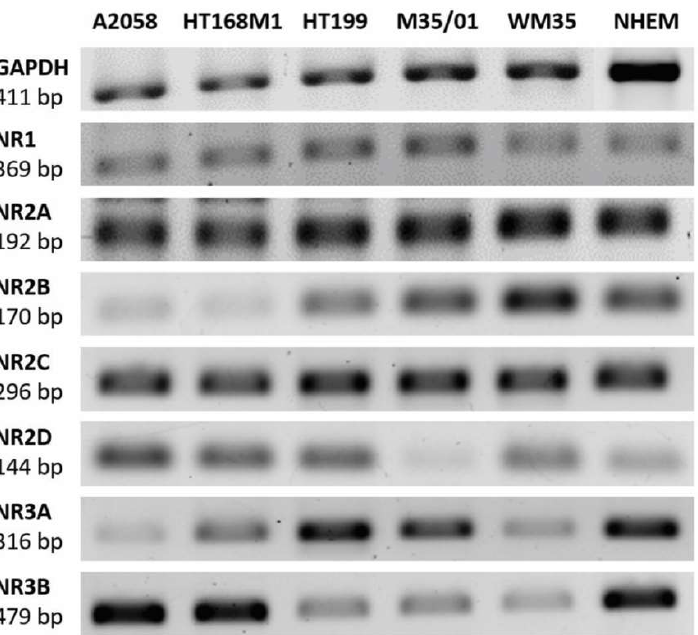
Figure 1. RT-PCR (reverse transcription followed by polymerase chain reaction) detection of NMDAR ( N -methyl- D -aspartate receptor) subunit mRNA expression in melanoma cells and melanocytes. RT-PCRs proved the presence of the essential NR1, the widely expressed NR2 and also the rare NR3 subunits in A2058, HT169M1, HT199, M35/01 and WM35 melanoma cell lines, as well as in NHEMs (normal human epidermal melanocytes). GAPDH (Glycerol aldehyde phosphate dehydrogenase) mRNA expression served as internal control to the reaction. The positive control for NMDAR subunit detection was human brain tissue sample (see Supplementary Information Figure S1). Normalization of the relative optical density parameters of the subunit mRNA expressions to GAPDH is shown in a graphical format in the Supplementary Information Figure S2.